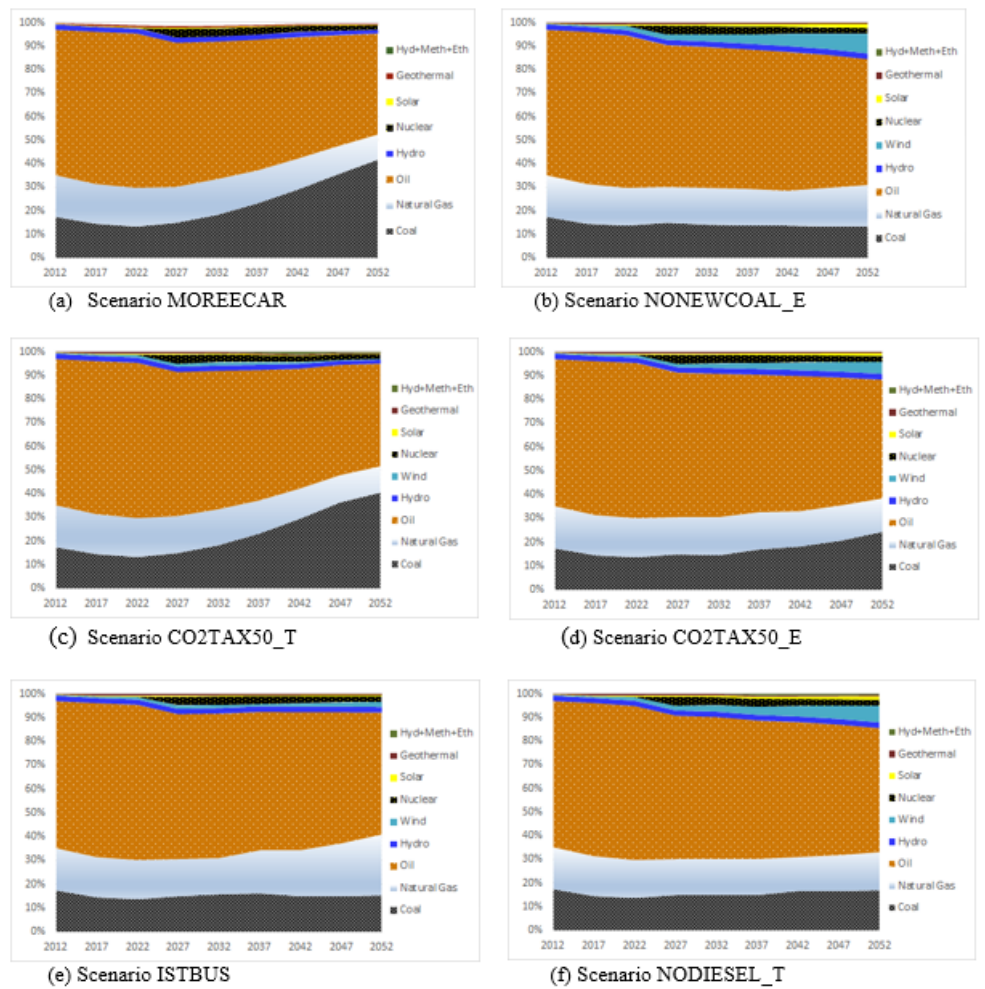
Figure 10. Primary energy supply mix in the alternative